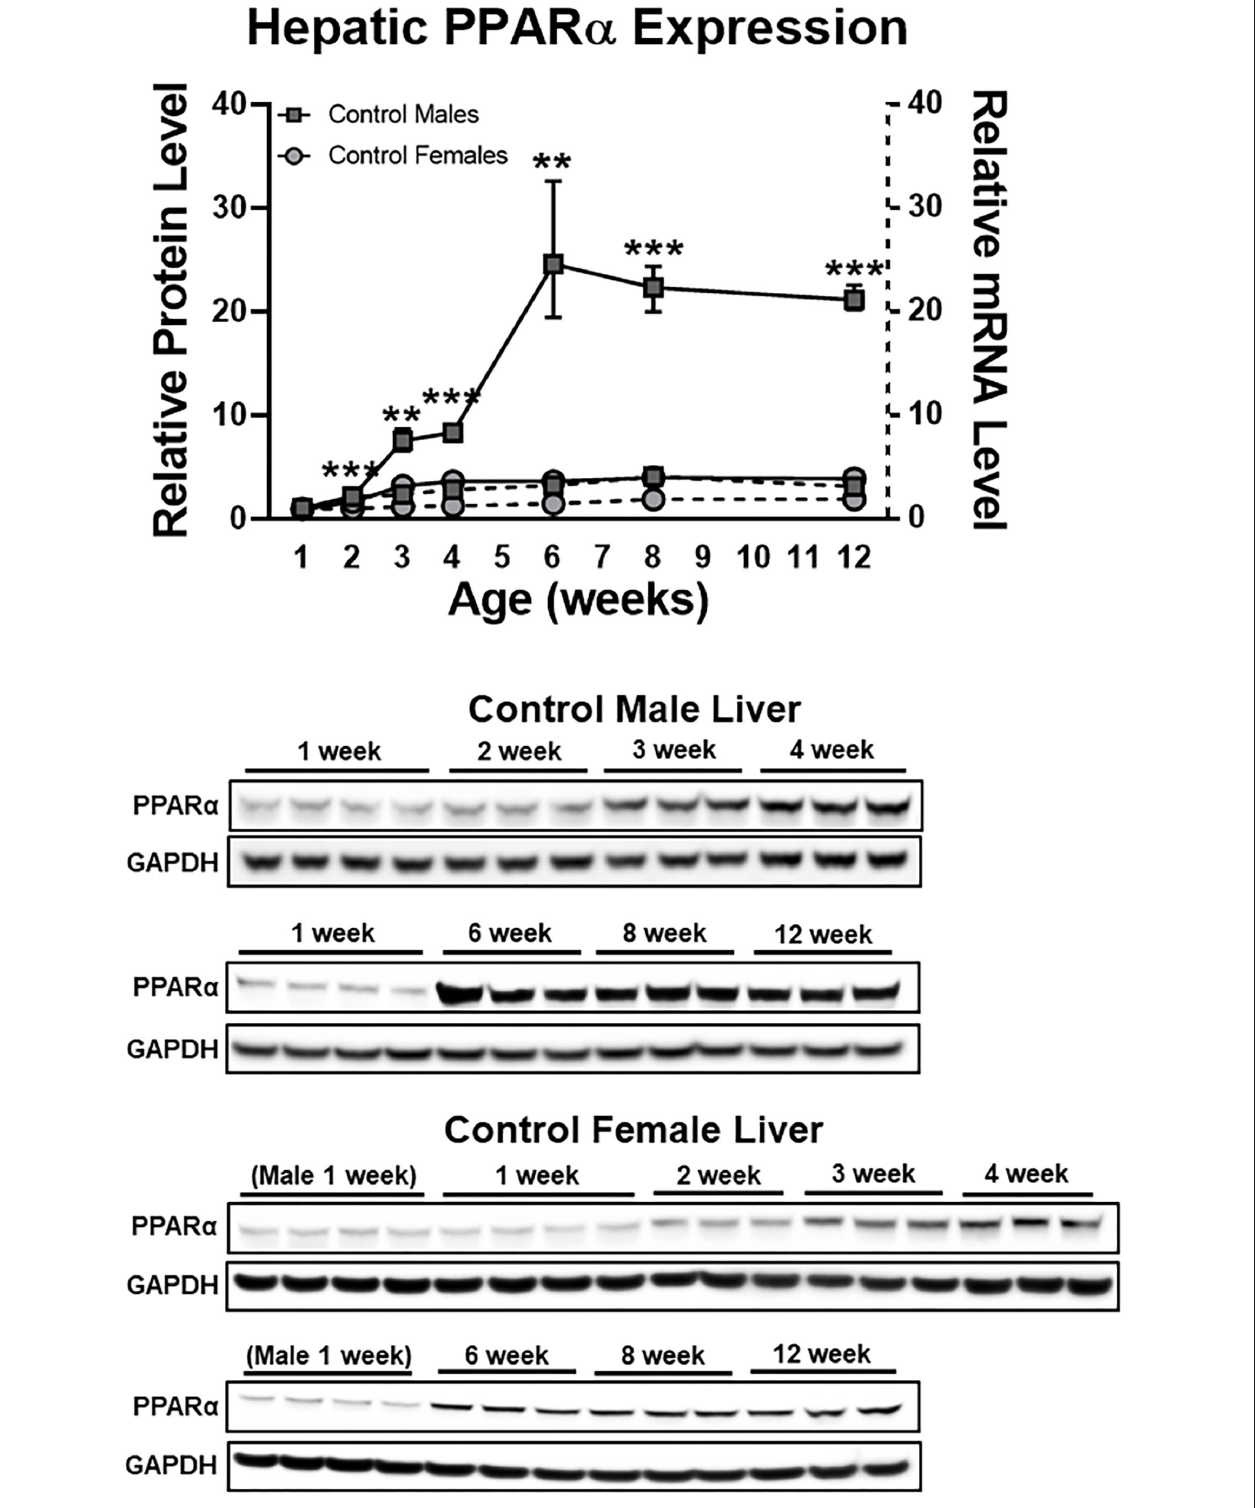
FIGURE 1 | Early life sex differences in hepatic PPAR α expression at the protein (solid lines) and mRNA (dashed lines) levels. Although sex differences were most striking with respect to protein expression, mRNA expression also was greater in males compared to females ( P < 0.05) at every time point after 1 week. N = 3–4 mice per time point per group; bars denote range. All data were normalized to 1 week old males. Mean + range; N = 3–4; *** P < 0.001; ** P < 0.01 between sexes at a given time point for protein expression. GAPDH, glyceraldehyde 3-phosphate dehydrogenase; PPAR α , peroxisome proliferator-activated receptor- α .